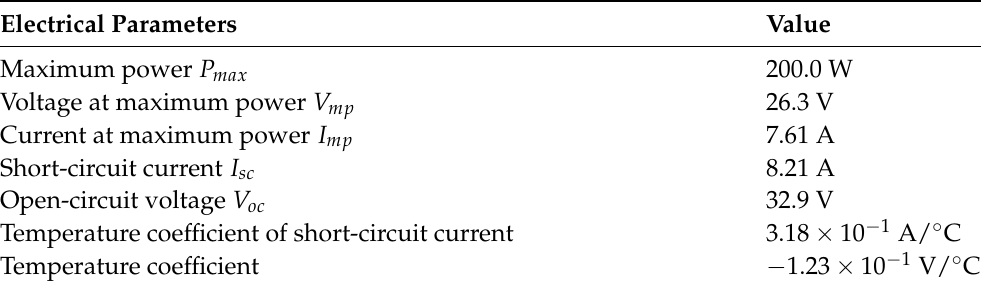
Table 1. Electrical characteristics of PV module